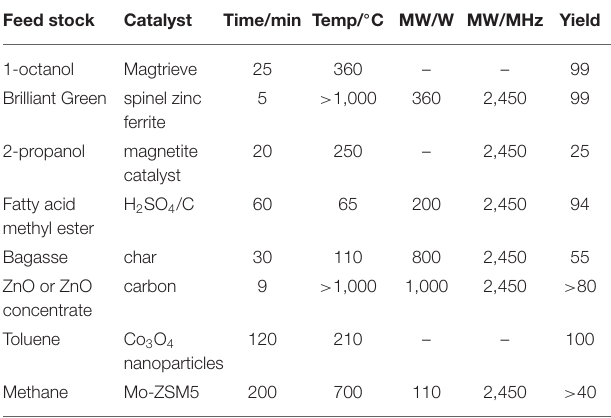
TABLE 1 | Summary of special thermal effect of microwave on solid